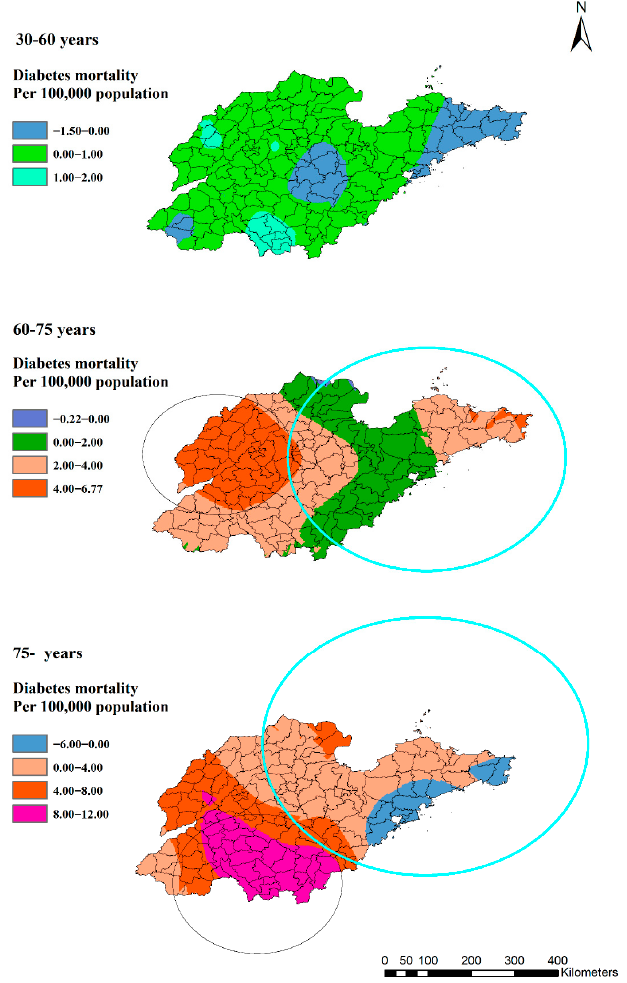
Figure 9. Differences in estimated diabetes mortality between winter and summer by age group with clusters.